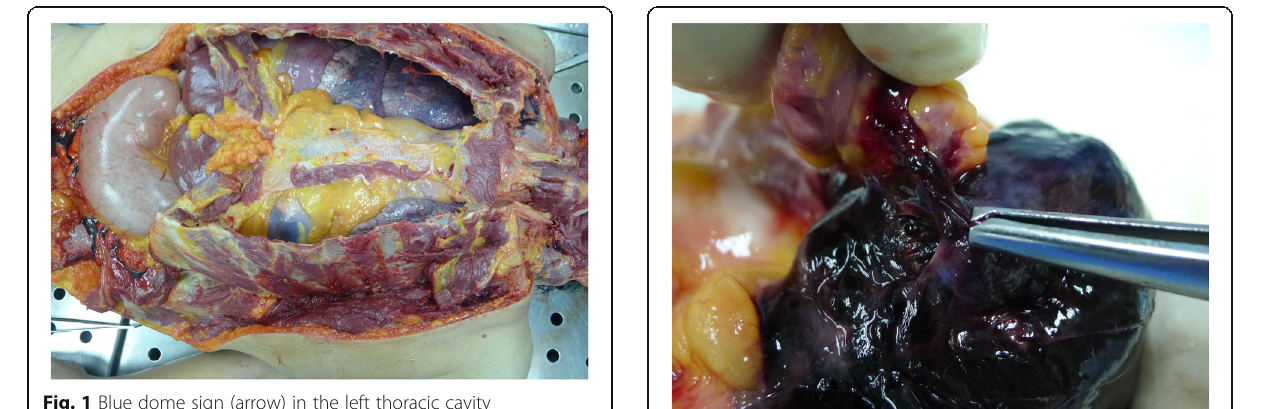
Fig. 1 Blue dome sign (arrow) in the left thoracic cavity